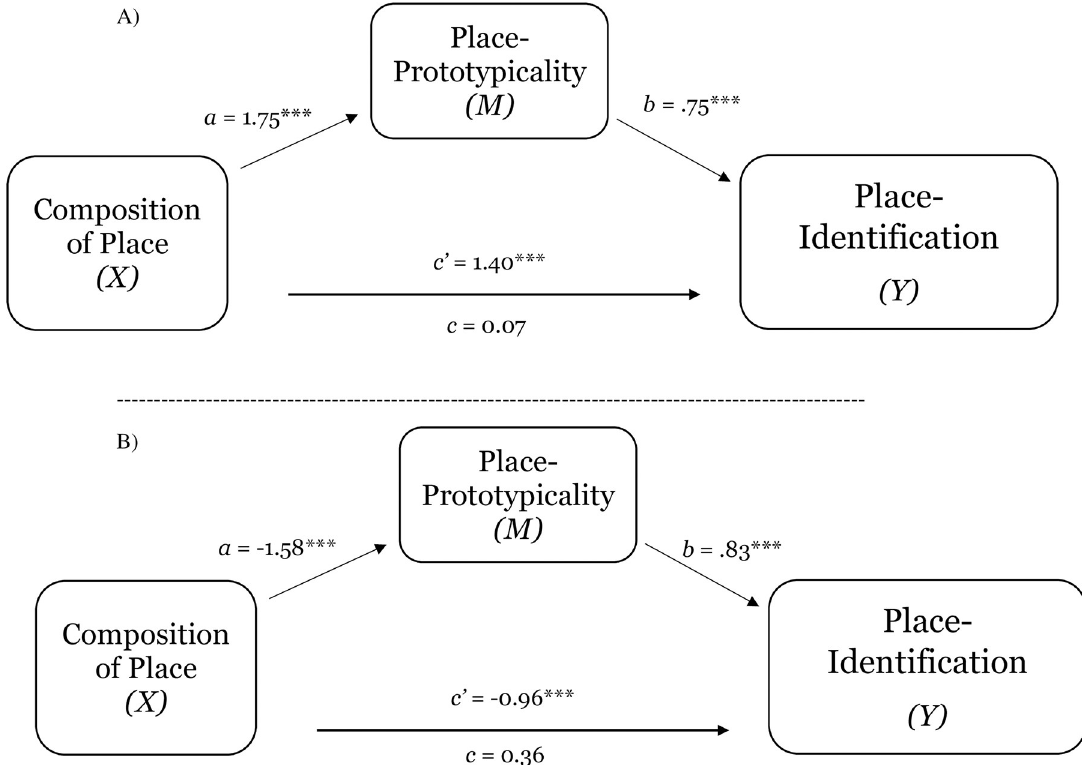
Fig 2. Test of the mediating effect of place-prototypicality on the relation between composition of place and place-identification (sense of belonging) in Study 1b (Panel A) and Study 1c (Panel B). Notes: � p < .05, �� p < .01, ��� p < .001.